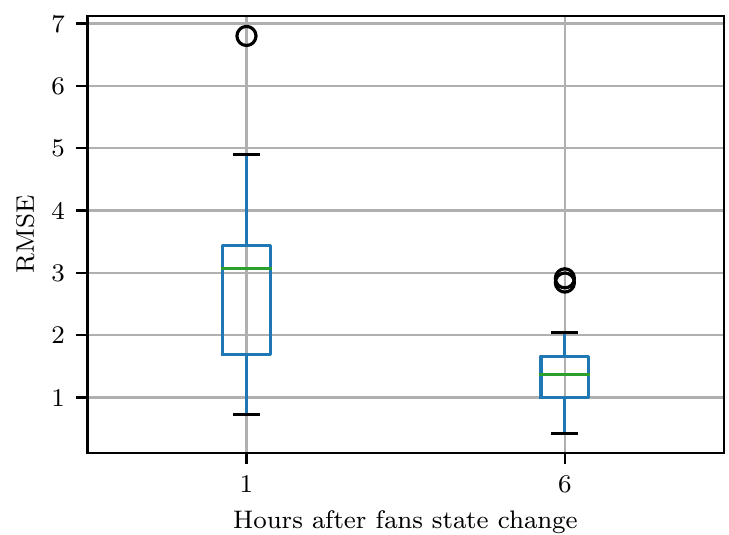
Figure 7. Box-plot of the temperature response of 13 fan state